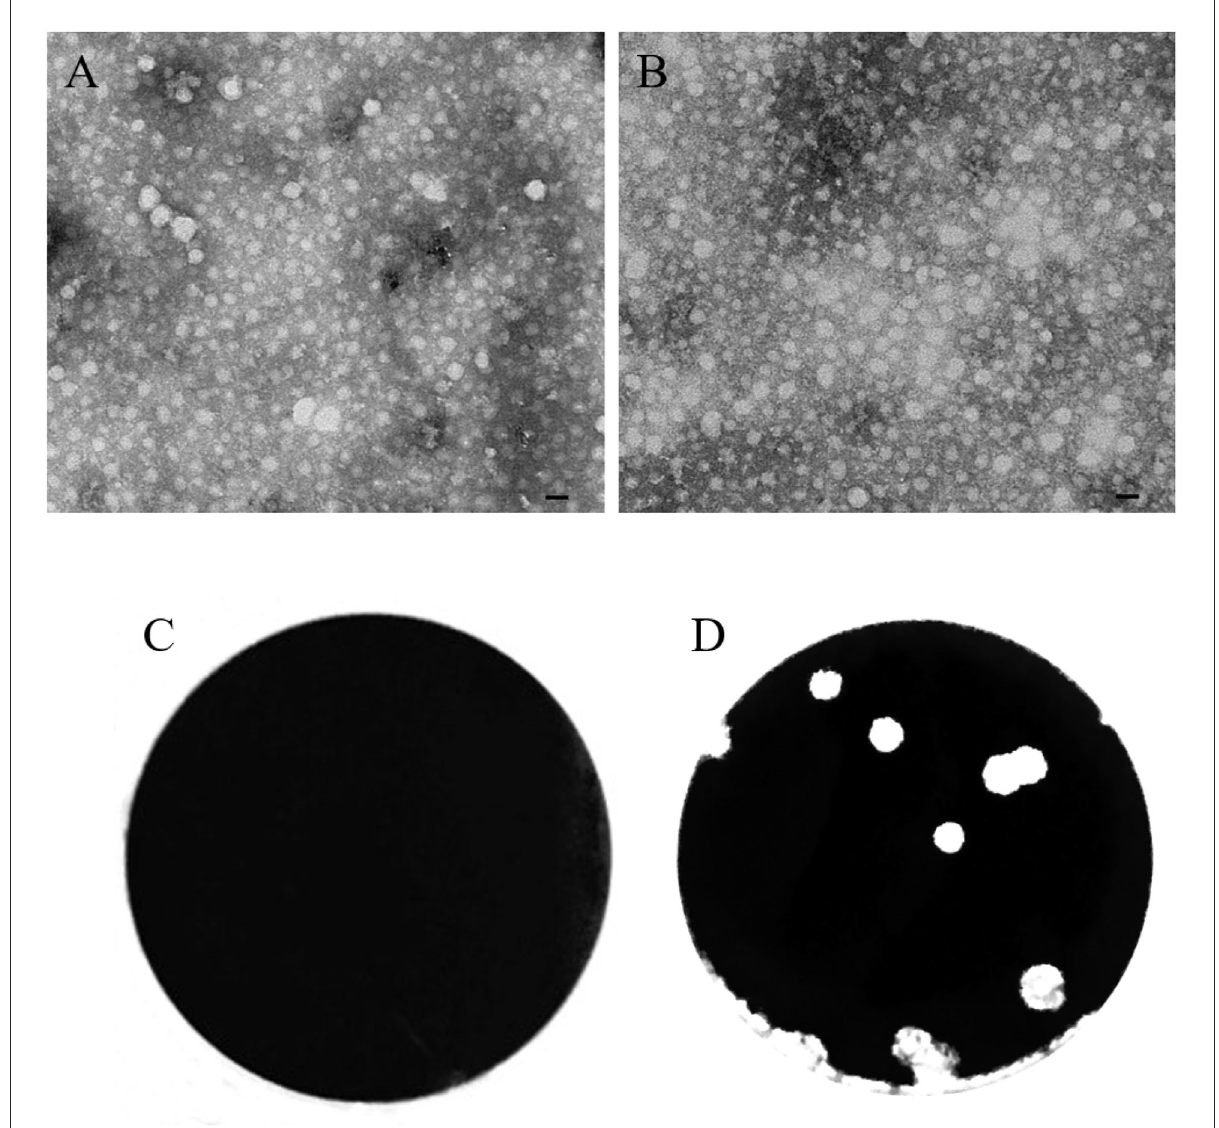
FIGURE3 Characterization of the recombinant WM01ma-HA (H5) influenza virus. Comparison of the morphologies of WM01ma (A) and the recombinant WM01ma-HA (H5) influenza virus (B) by scanning electron microscopy (scale bar 100nm), plaque formed by the recombinant WM01ma-HA (H5) influenza virus on wild-type MDCK cells (C) and MDCK cells stably expressing the NA protein (D)